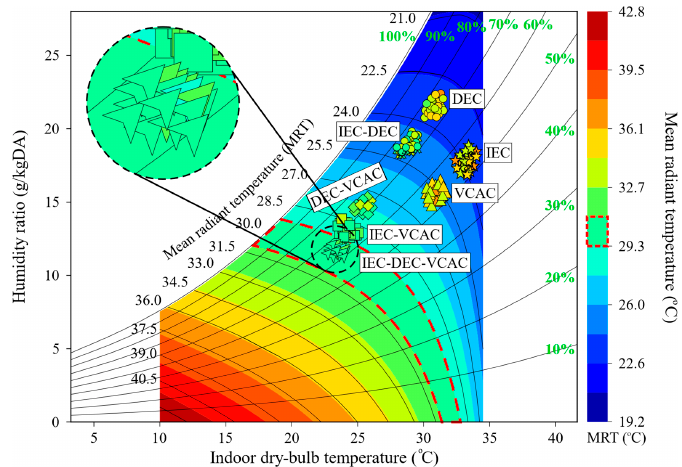
Figure 7. Profile of thermal comfort correlating with MRT for all the seven AC configurations. From the PMV and PPD point of view, hourly annual thermal comfort sensation resulted from the seven AC configurations and is presented in Figure 8. All the proposed AC configurations achieved thermal comfort at some point or another throughout the whole year. However, on 19 June, all the hybrid EC systems (i.e., DEC-VCAC, IEC-VCAC and IEC-DEC-VCAC) achieved neutral to slightly cool thermal sensation with PPD variation of 30% to 40% (Figure 8).